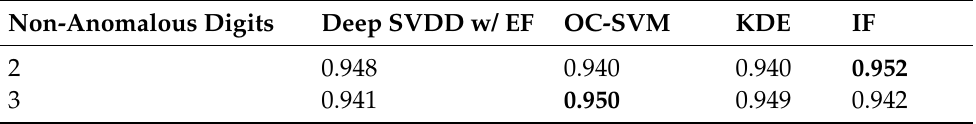
Table 6. ROC AUC results for anomaly detection on multi-perspective MNIST [9] dataset using the denoising early fusion technique (Deep SVDD w/ EF). In addition, the results of the shallow anomaly detection methods OC-SVM, KDE and IF (see Section 3.1) are listed. The numbers for Deep SVDD and IF are average values for 3 and 60 experiments,